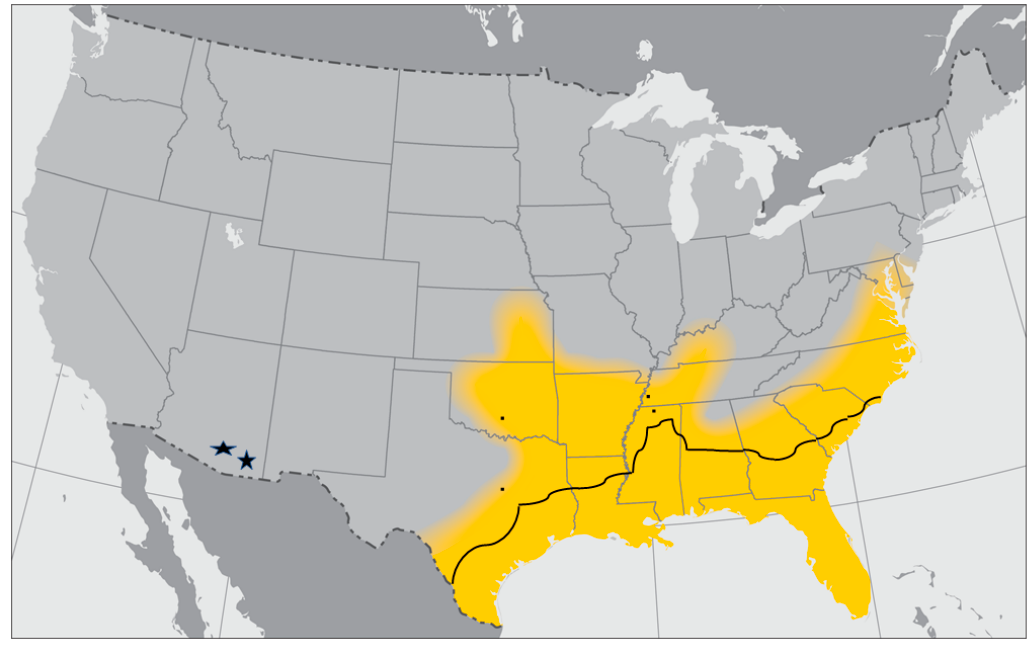
Figure 2. Map showing the current versus the historic geographic distribution of the Gulf Coast Tick, Amblyomma maculatum (yellow distribution based on [24] and CDC map). Dark black line and the four isolated black dots indicate the historic distribution based on Bishop and Trembley [32]. Asterisks in southeastern Arizona indicate new established populations as reported by Allerdice et al. [26]. Photo